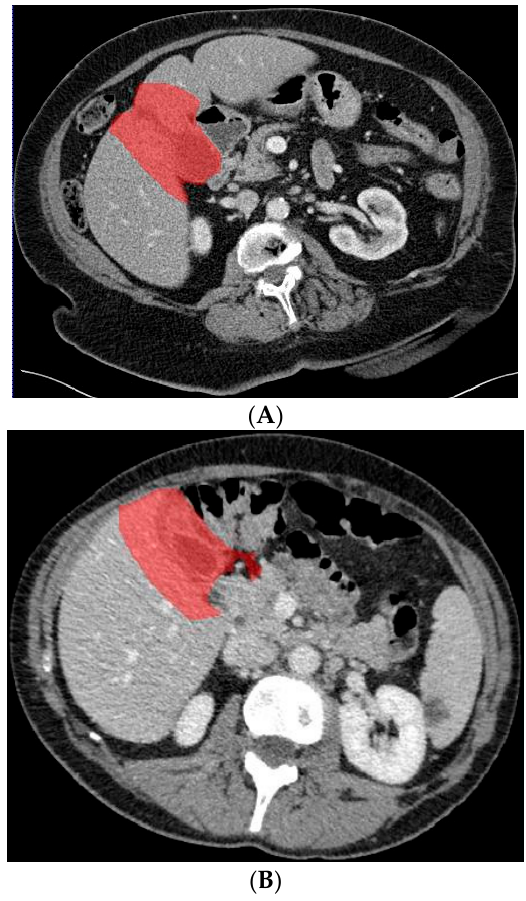
Figure 4. Axial CT slices with examples of segmented gallbladder including 2 cm of adjacent liver parenchyma (( A ) gallbladder cancer case from Figure 2, and ( B ) benign gallbladder disease case from Figure 3).